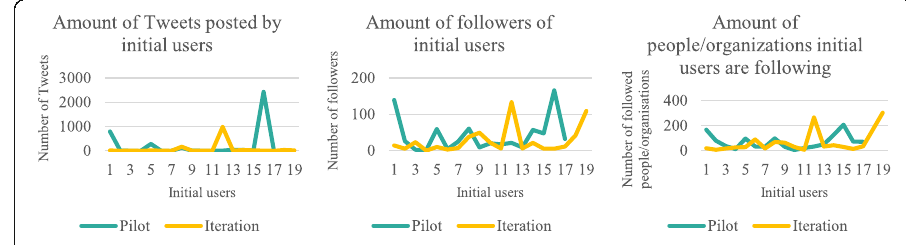
Fig. 2 Descriptives of initial Twitter use (pilot: n = 17; iteration: n =